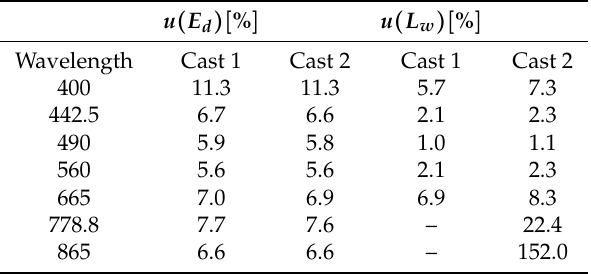
Table 7. Final standard uncertainty values for corrected non-ideal case expressed in